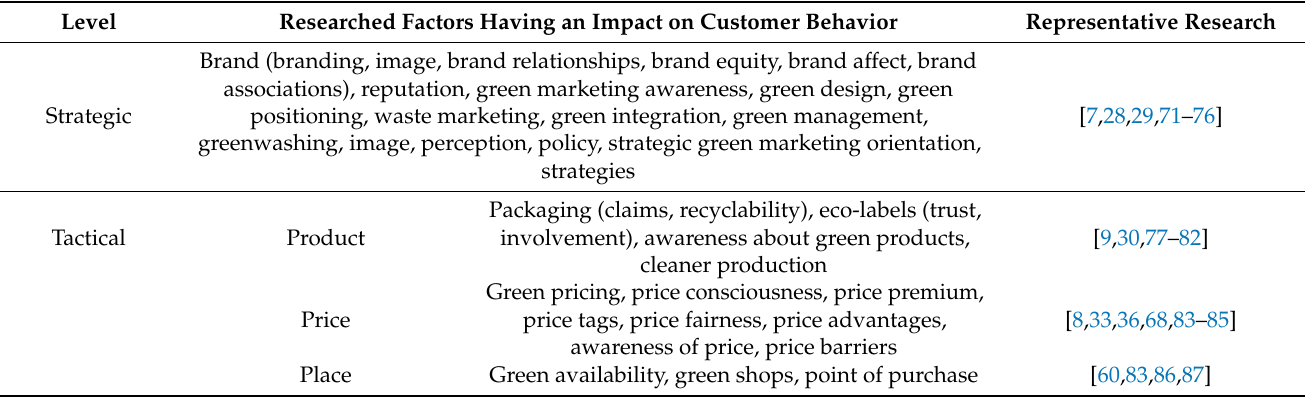
Table 5. The green marketing factors that have an impact on customer